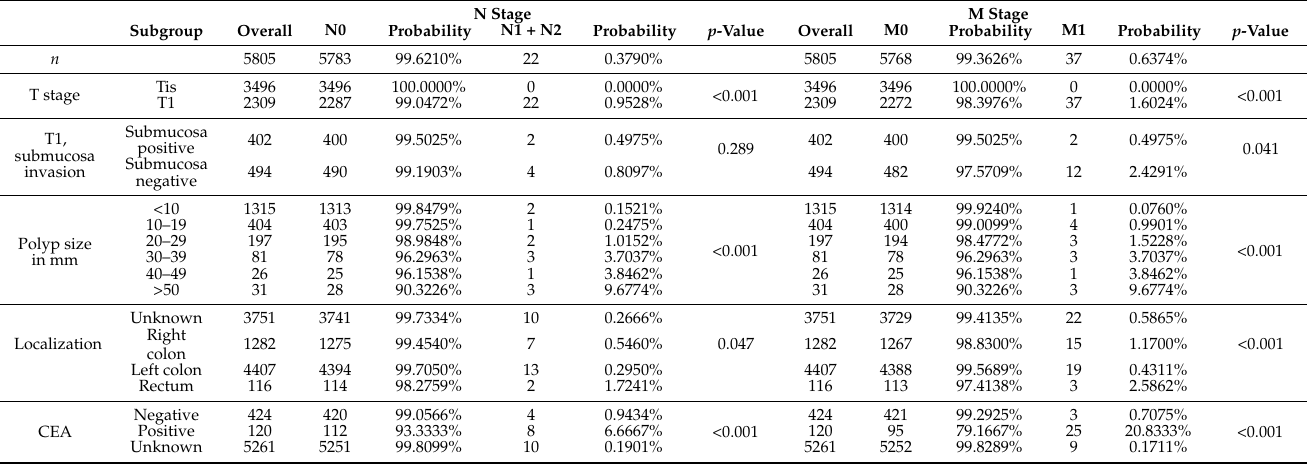
Table 4. The migration of lymph nodes and distant tissue/organs across all patients with endo- scopic polypectomy.